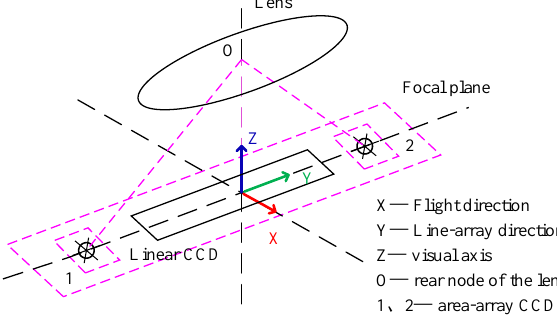
Figure 5. Initial positional